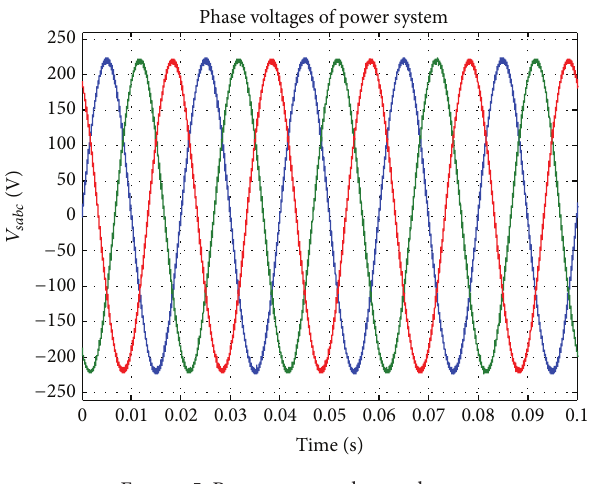
Figure 5: Power system phase voltages.